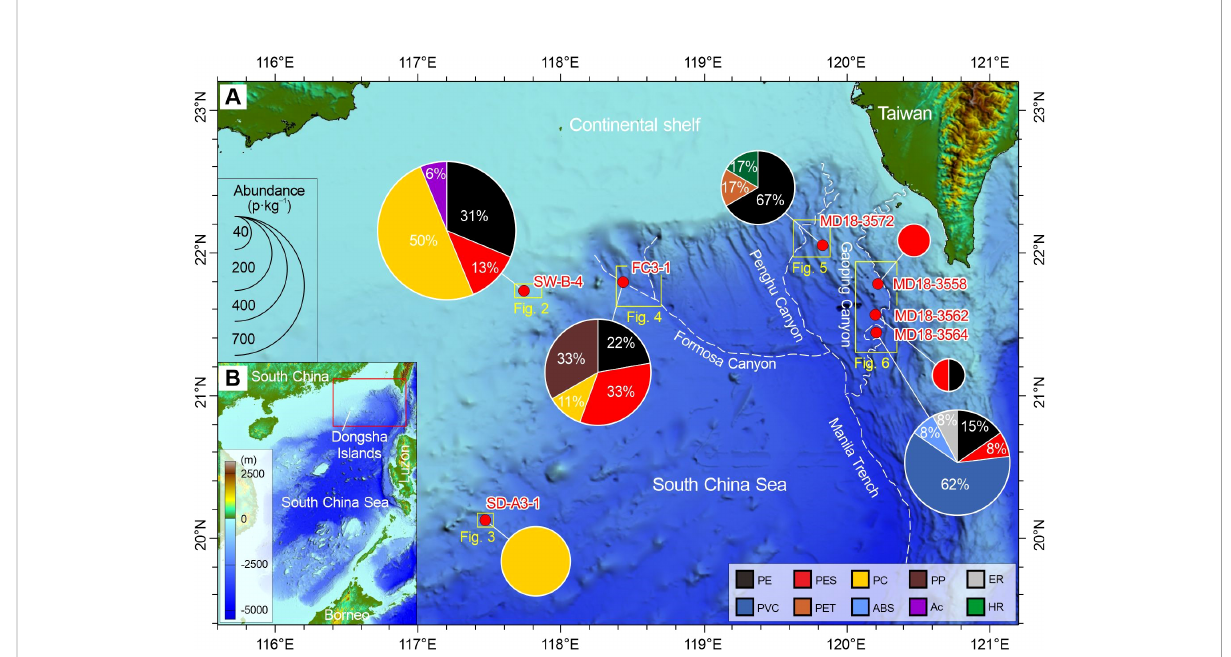
positions of these samples are included in Table 1. Pie charts display the spatial distribution of microplastic compositions in sediment samples. The area of the pie chart represents the total abundance of microplastics in p·kg – 1 (particles per kilogram). Abbreviations for polymers are polyethylene (PE), polyester fi ber (PES), polycarbonate (PC), polypropylene (PP), epoxy resin (ER), polyvinyl chloride (PVC), polyethylene terephthalate (PET), acrylonitrile-butadiene-styrene (ABS), acrylic (Ac), and hydrocarbon resin (HR). The detailed data are shown in Table 2. (B) Bathymetry of the South China Sea and adjacent continents and islands. The red box shows the location of the map (A)